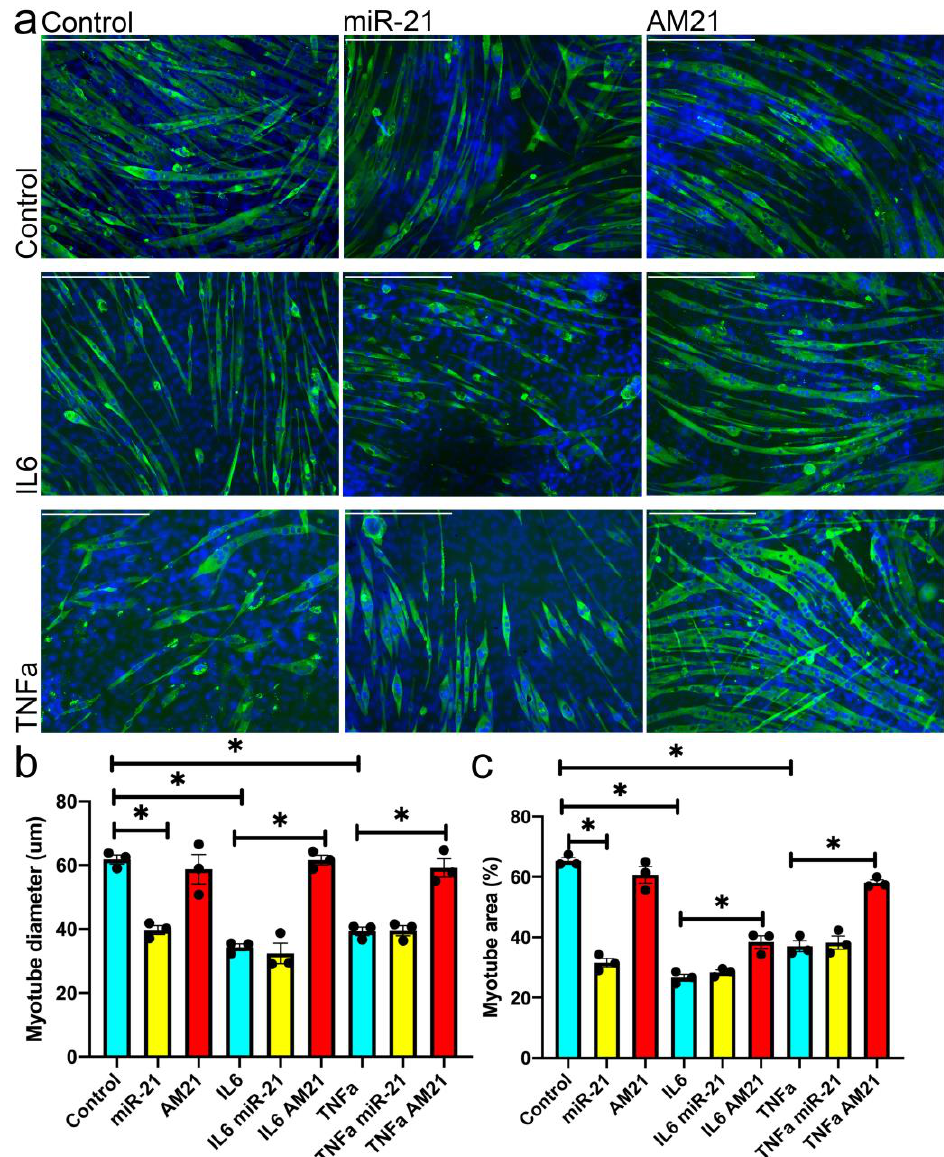
Figure 4. Inhibition of miR-21 positively regulates myogenesis in the presence of pro-inflammatory cytokines. ( a ) MF20 immunostaining showing myogenic differentiation regulation by miR-21 in the presence of 0.2 ng/mL interleukin 6 (IL6) or 25 ng/mL TNFα for 5 days, respectively. Expression of miR-21 was manipulated in undifferentiated myoblasts using miR-21 mimic or anti-miR-21 (AM21) in the presence of IL6, TNFα, respectively; control—mock-transfected cells. Myotubes were stained for myosin heavy chain: MF20—green; blue—DAPI. ( b ) Quantification of myotube diameter is shown. ( c ) Quantification of total myotube area is shown (%). Error bars show SEM, • indicates individual replicates, * p < 0.05 (compared to control), n = 3. Scale bar = 400 µ